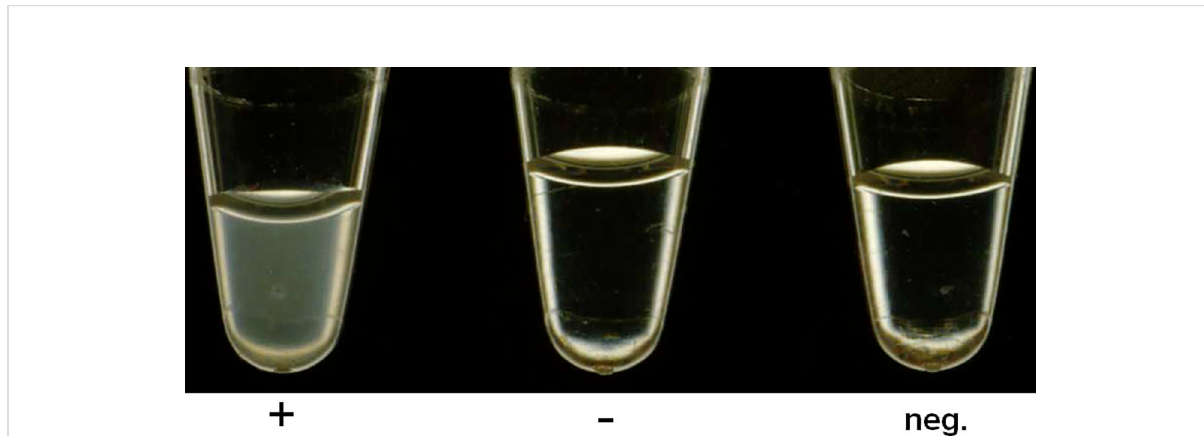
FIGURE 1 bla KPC -LAMP assay detecting Visual detection of a white precipitate in positive samples. The fi gure shows a positive ( bla KPC-2 ) and a negative (non- bla KPC , bla NDM-1 ) sample, together with a negative control